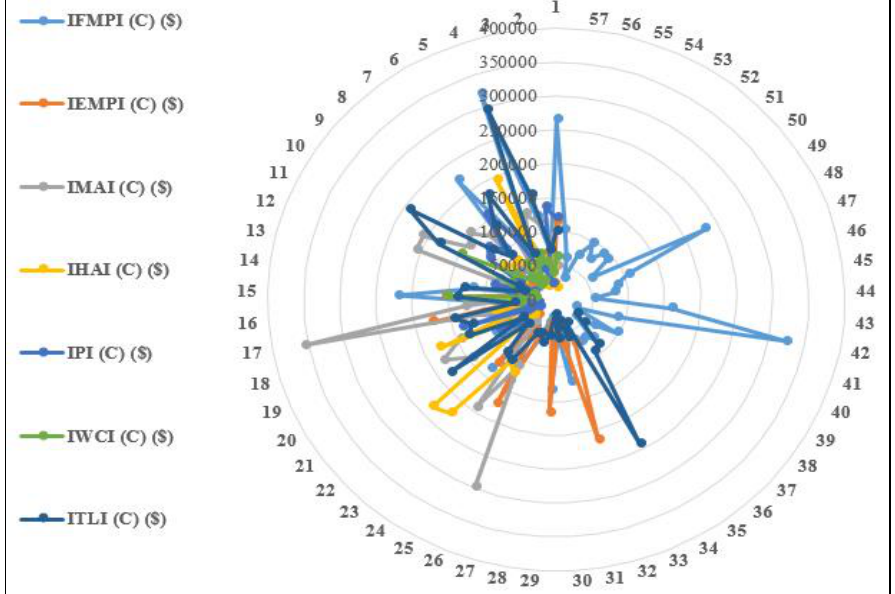
Figure 2: The costs (energy stream) of industrial groups.